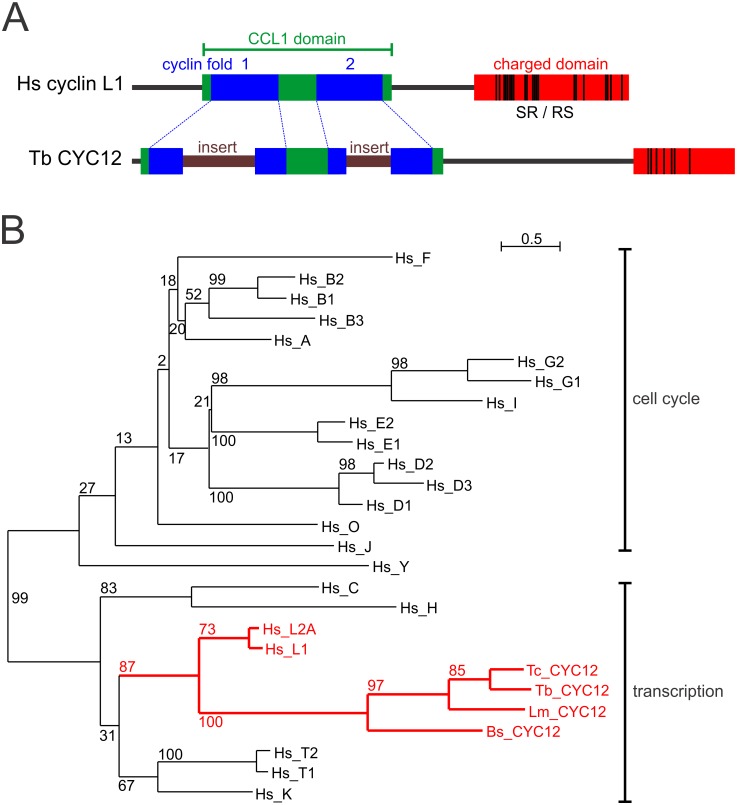
Cyclin CYC12 is an L-type cyclin.(A) Schematic drawing to scale of the human L1 and T. brucei CYC12 cyclins. The two cyclin folds (blue) are embedded in the CCL1 domain (green). The charged RS domain (red) was defined by a hydrophilicity Kyte & Doolittle blot score of < -2. Black lines indicate SR or RS dipeptides. Both cyclin domains of CYC12 are disrupted by insertions. (B) Phylogenetic tree, generated by the maximum likelihood algorithm and based on a multiple sequence alignment of the cyclin domains of human cyclins and of CYC12s from T. brucei (Tb), T. cruzi (Tc), L. major (Lm) and the bodonid Bodo saltans (Bs) (for accession numbers see S5 Fig). Cyclins involved in the cell cycle and in transcriptional control are indicated. Bootstrap values are indicated in percentages and were derived from 1000 replicates. The common branch of human cyclins L and kinetoplastid CYC12s is drawn in red.